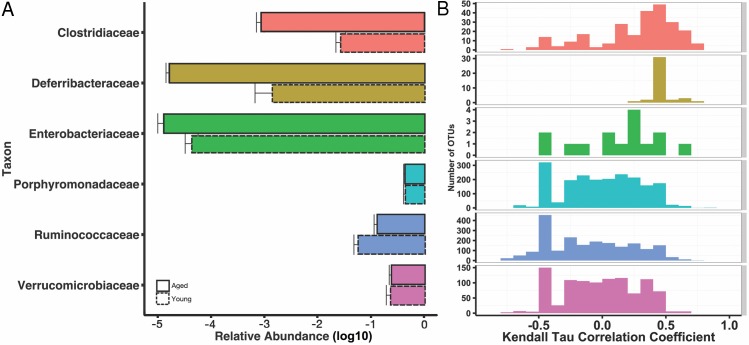
Some age-associated differences in mouse gut microbiome also correlate with inflammatory marker MCP-1.(A) Selected significant taxonomy representing differences between young (dotted line) and aged (solid line) at the family level, expressed as mean relative abundances on a log10 scale. (B) Histograms for Kendall tau correlation coefficients representing the complex relationship between individual OTUs and serum MCP-1 by taxonomic family. Certain family level differences observed between young and aged mice also appear to correlate with pro-inflammatory marker, serum MCP-1.